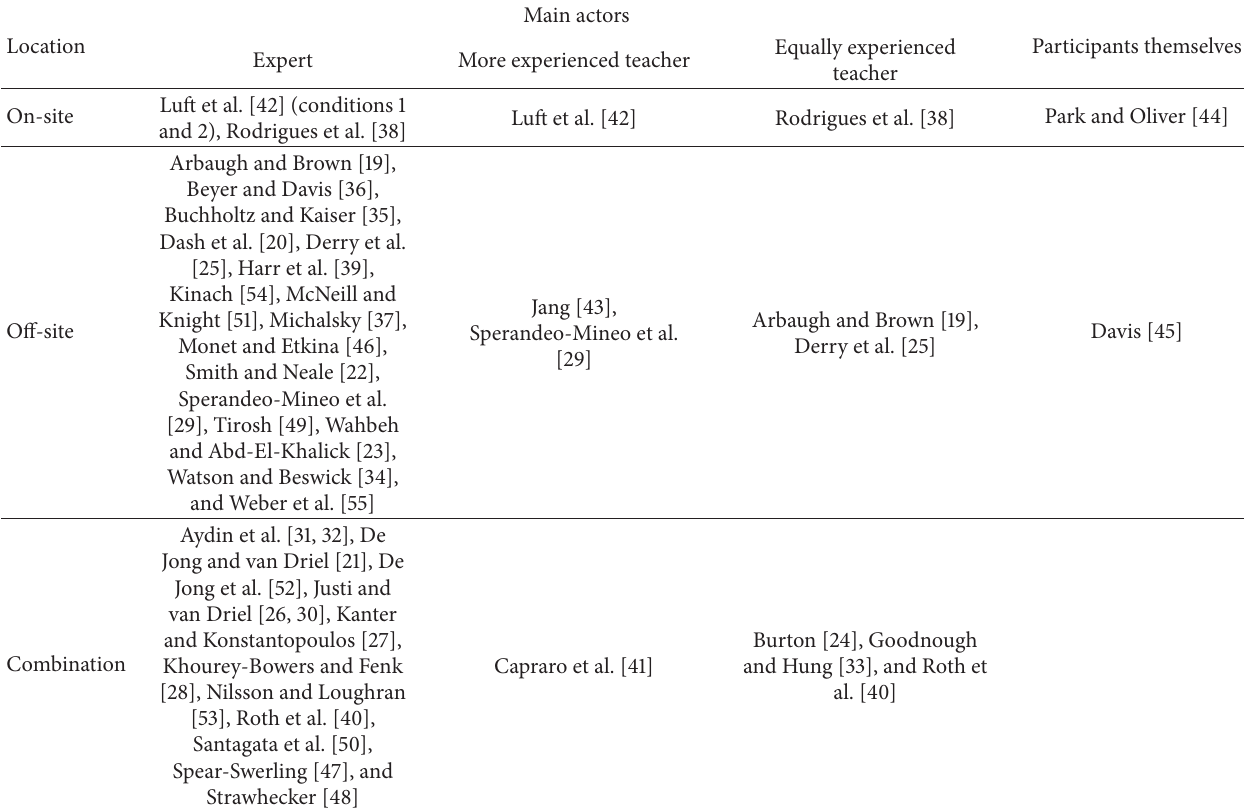
Table 4: Overview of the location of the interventions and of main actors in the